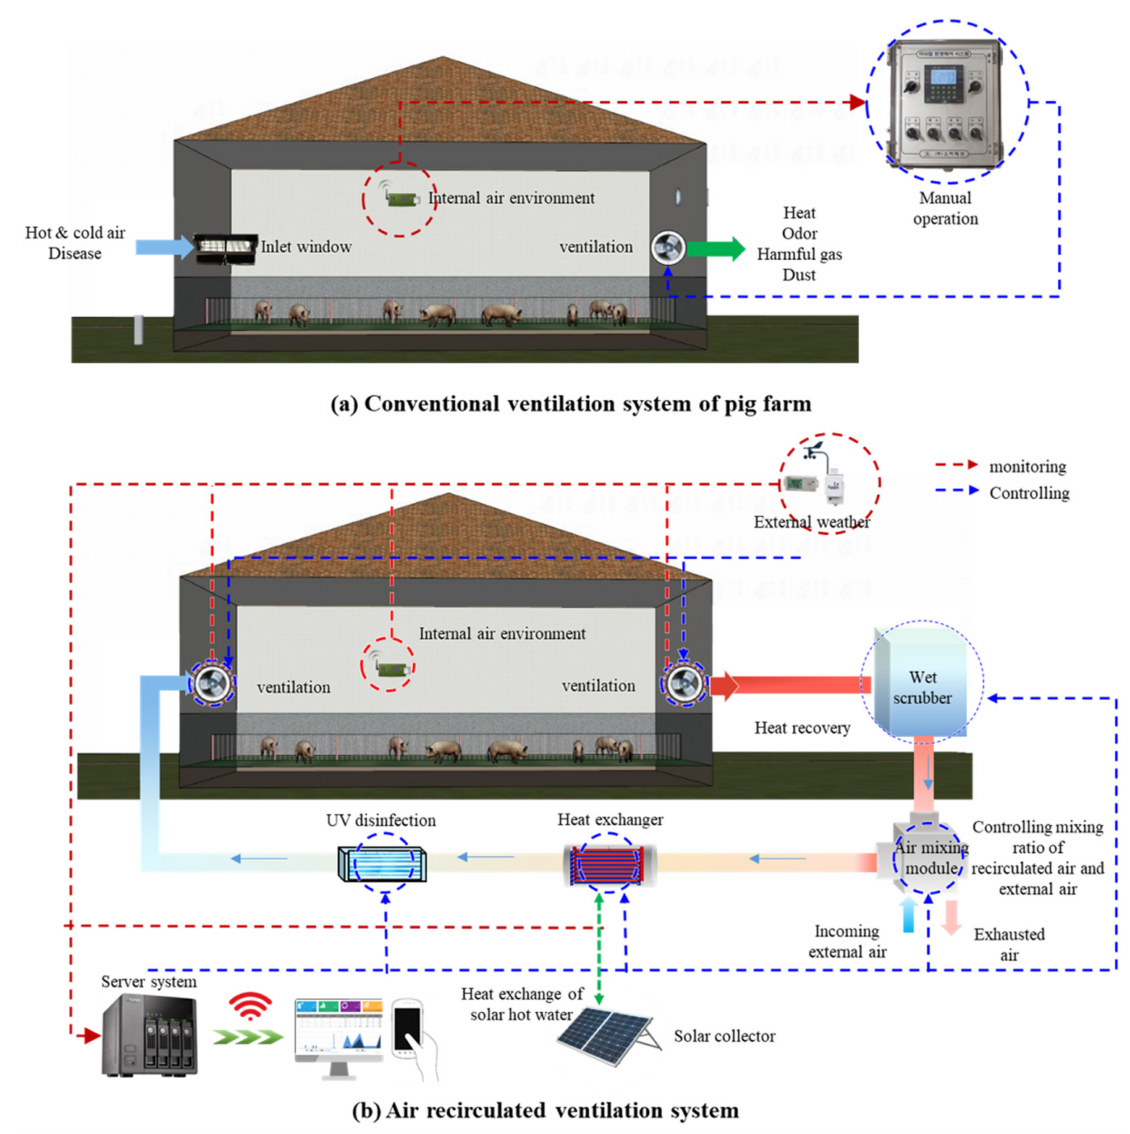
Figure 1. Schematic diagram of the conventional ventilation system and the developed ARVS. The conventional ventilation system ( a ) uses external air directly and exhausts internal air. The ARVS ( b ) reuse the internal air for